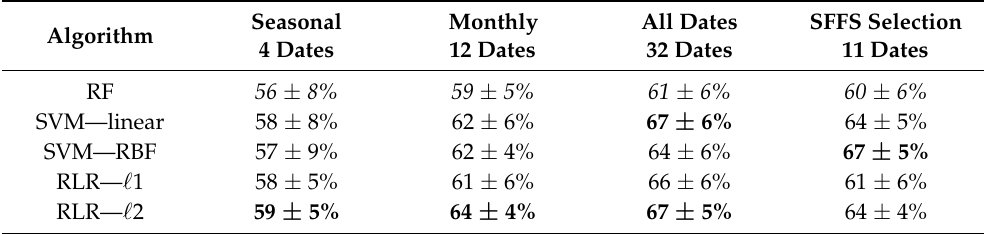
Table 7. Average Overall Accuracy and corresponding standard deviations obtained with the different temporal selections. The highest AOA are in bold and the lowest in